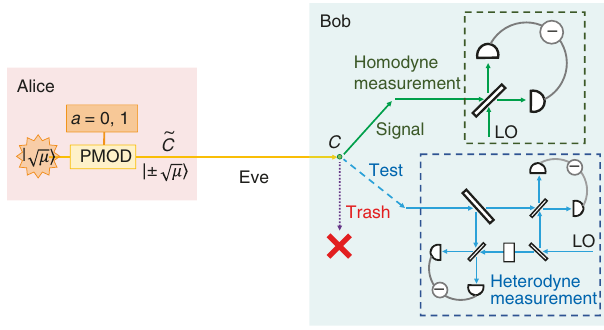
Fig. 2 The proposed continuous-variable quantum key distribution protocol. Alice generates a random bit a ∈ {0, 1} and sends a coherent ffiffiffi μ p . Bob chooses one of the three measurements state with amplitude ð(cid:2) 1 Þ a based on the predetermined probability. In the signal round, Bob performs a homodyne measurement on the received optical pulse and obtains an outcome ^ x . In the test round, Bob performs a heterodyne measurement on the received optical pulse and obtains an outcome ^ ω . In the trash round, he produces no outcome.